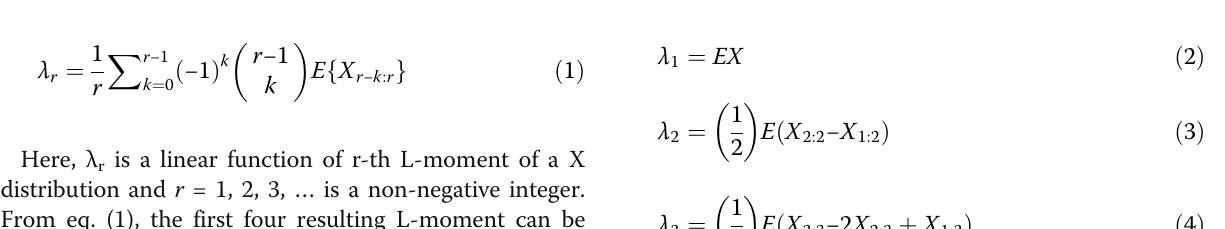
One-day max. Rainfall (mm)